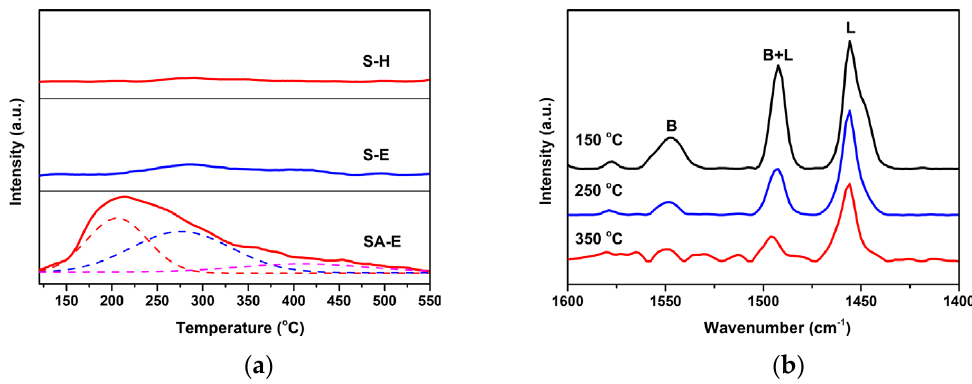
Figure 10. NH 3 - TPD profiles of Samples S - H, S - E, and SA - E ( a ), and pyridine - FTIR spectra of Figure 10. NH 3 -TPD profiles of Samples S-H, S-E, and SA-E ( a ), and pyridine-FTIR spectra of Sample Sample SA - E after degassing at different temperature ( b ). SA-E after degassing at different temperature ( b